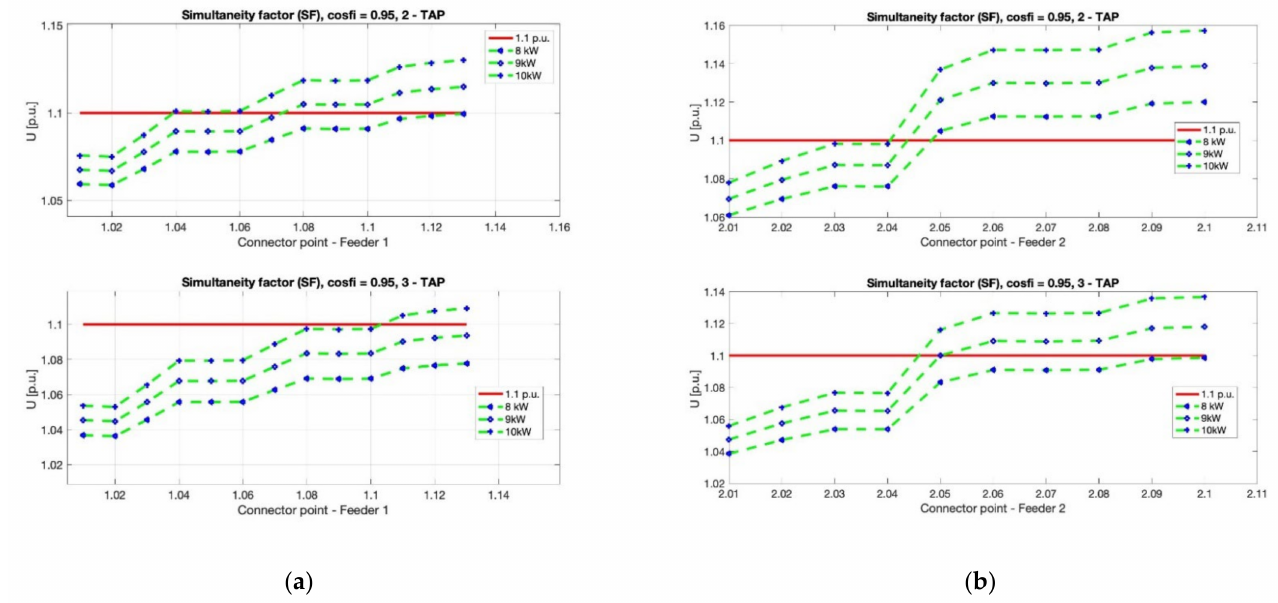
Figure 5. Scenario SF, power factor = 0.95, TAP-2 and 3, Feeder 1—( a ) and Feeder 2—( b ).